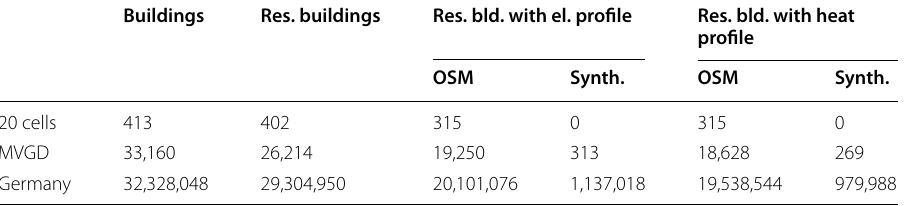
Table 4 OSM buildings, residential buildings and residential buildings with profiles assigned per aggregation level. OSM: from OSM, Synth.: synthetically created